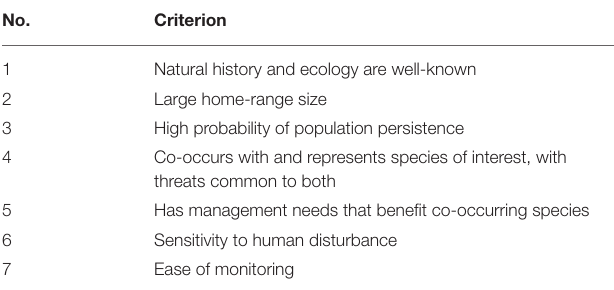
TABLE 4 | Criteria for selecting an umbrella species (modified from Seddon and Leech, 2008 ).